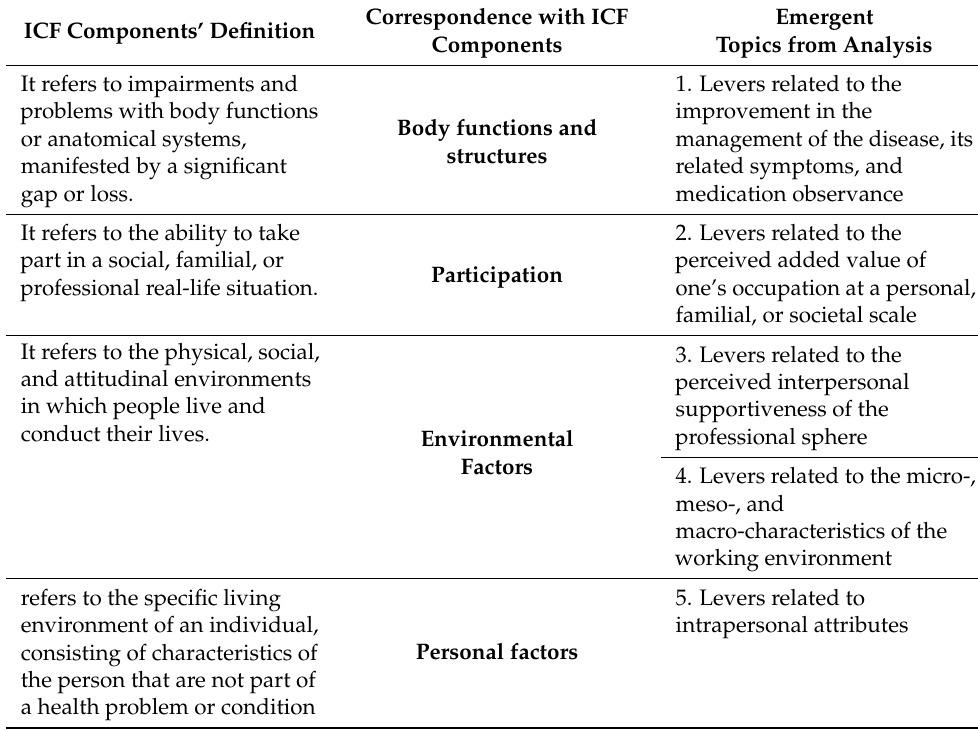
Table 3. Correspondence of the emergent topics from data analysis with ICF